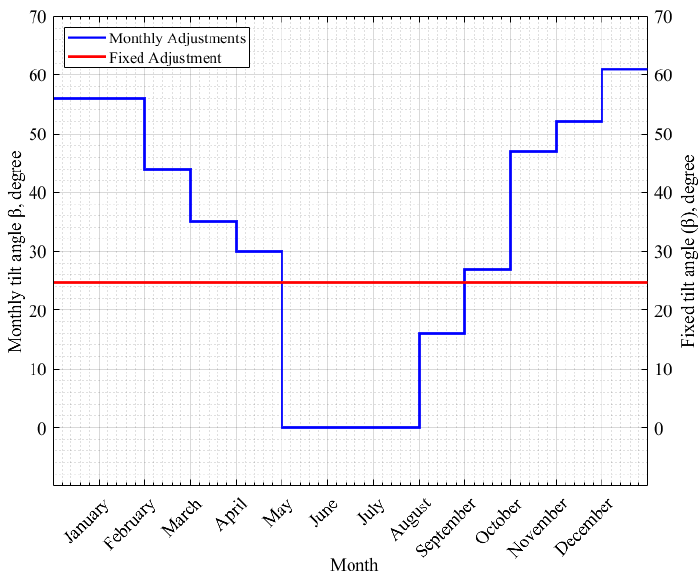
Figure 10. The variation of the optimal monthly tilt angle vs. the optimal fixed tilt angle.